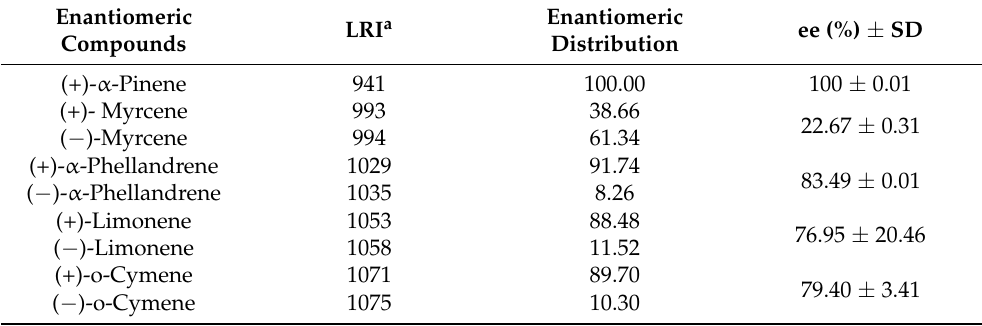
Table 2. Enantiomeric GC analysis of Hedyosmum purpurascens EO.